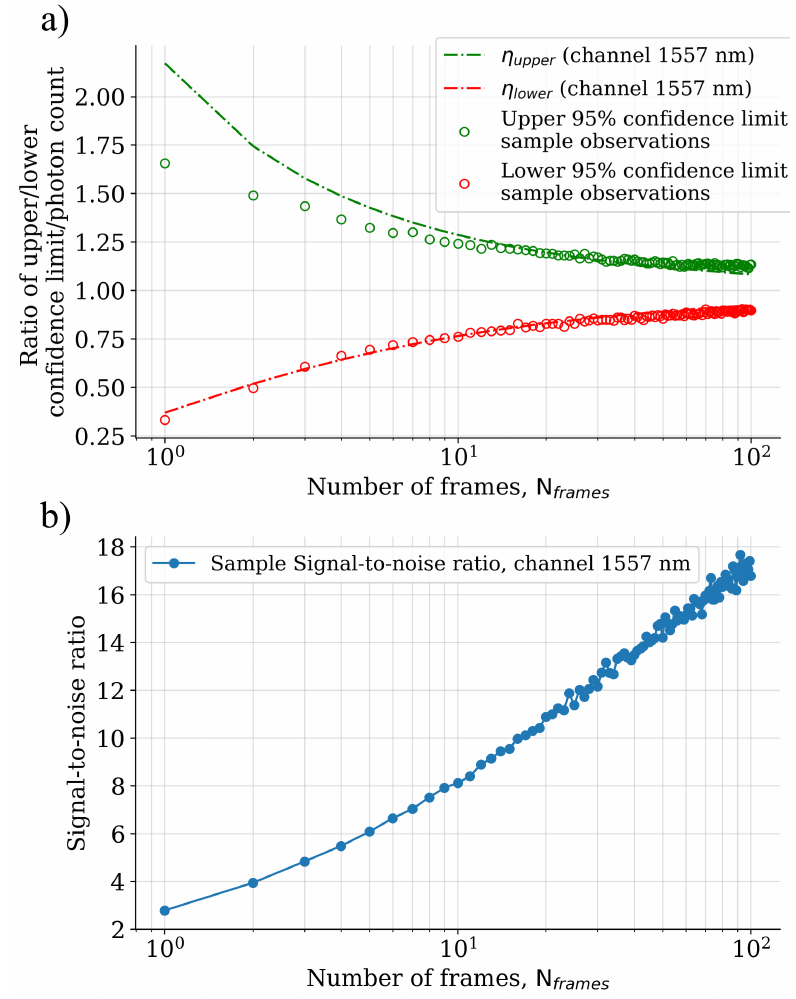
Figure 15. ( a ) The theoretical spectral reflectance measurement accuracy confidence limits η lower and η upper , and the relative confidence limits computed from the empirical distribution function with respect to the block size. ( b ) The signal-to-noise ratio as a function of the block size. The observations have been computed from the Spectralon 40% sample. The average photon count for channel λ x = 1557 nm was approximately E [ S ( λ x )] ≈ 6.04 photons per